Question: Name the type of graph shown.
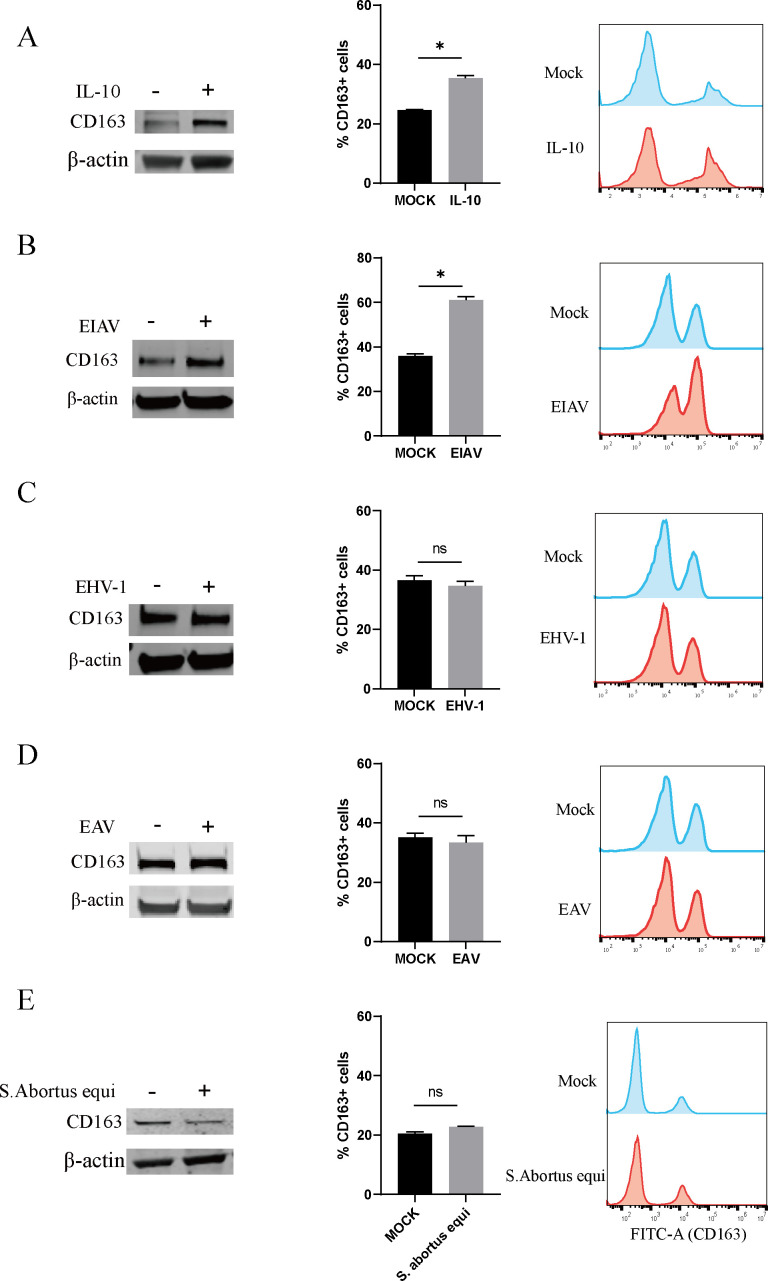
Answer: histogram